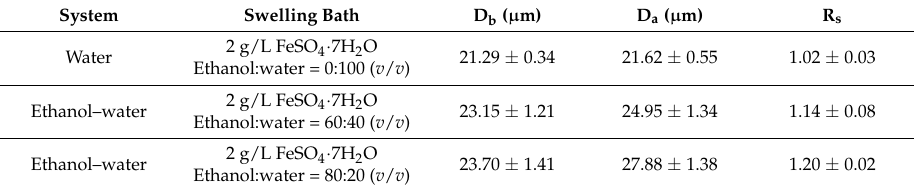
Table 3. Average values of diameters and swelling ratios for camel hair obtained by the optical method.